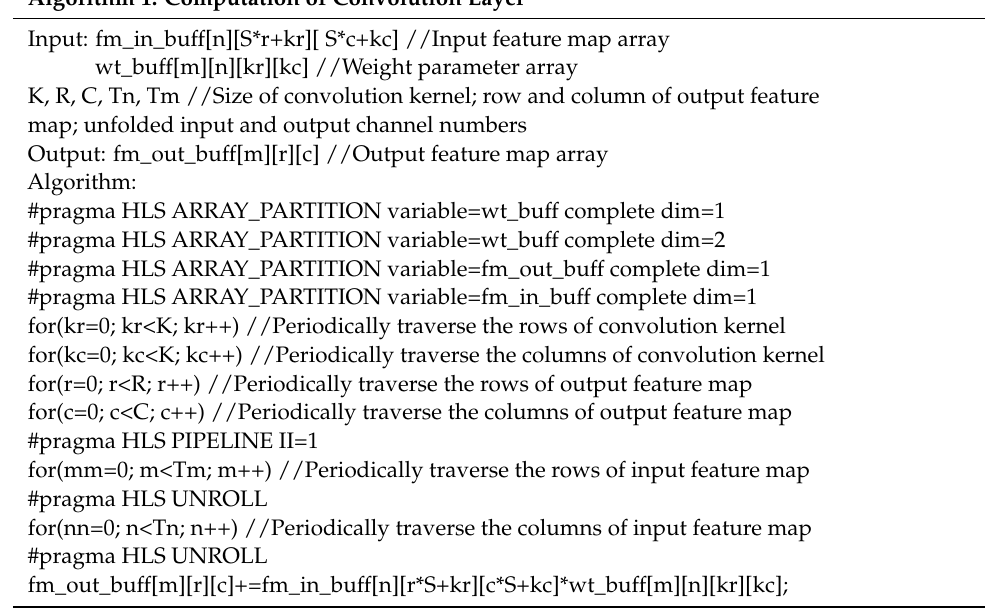
Algorithm 1. Computation of Convolution Layer